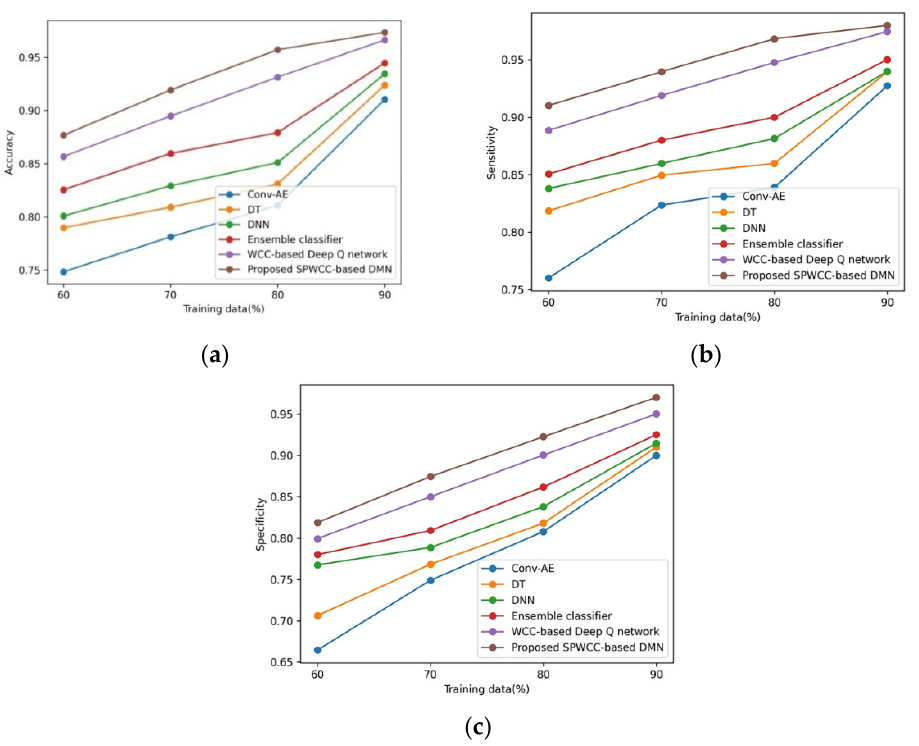
Figure 5. Assessment of techniques with DoS attack considering ( a ) accuracy, ( b ) sensitivity, and ( c ) specificity.